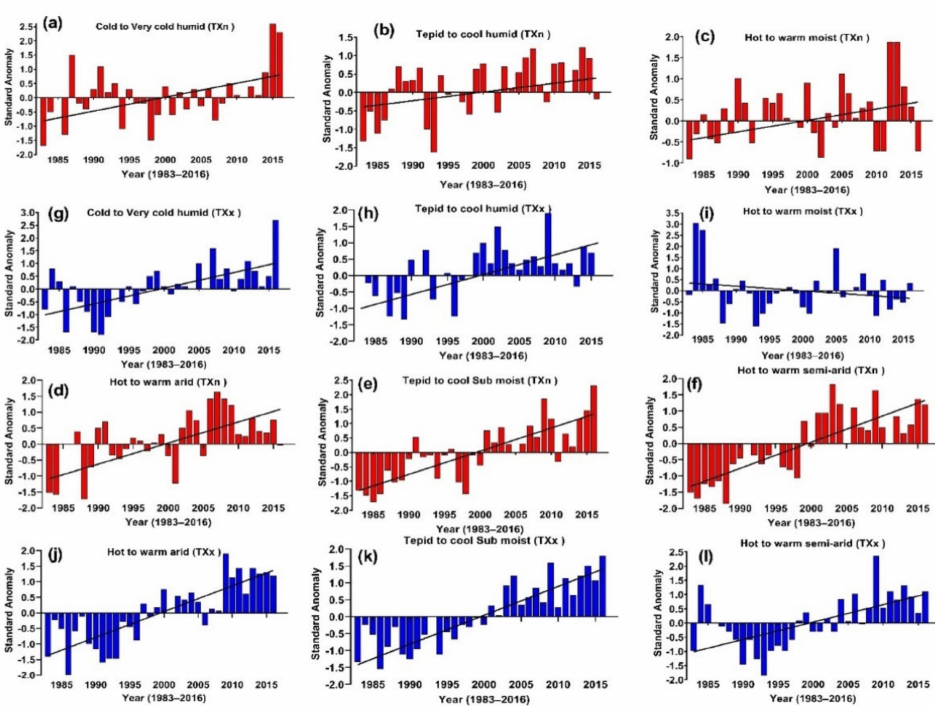
Figure 6. The coldest day (TXn) ( a – f ) and warmest day (TXx) ( g – l ) over agroecological zones for the period